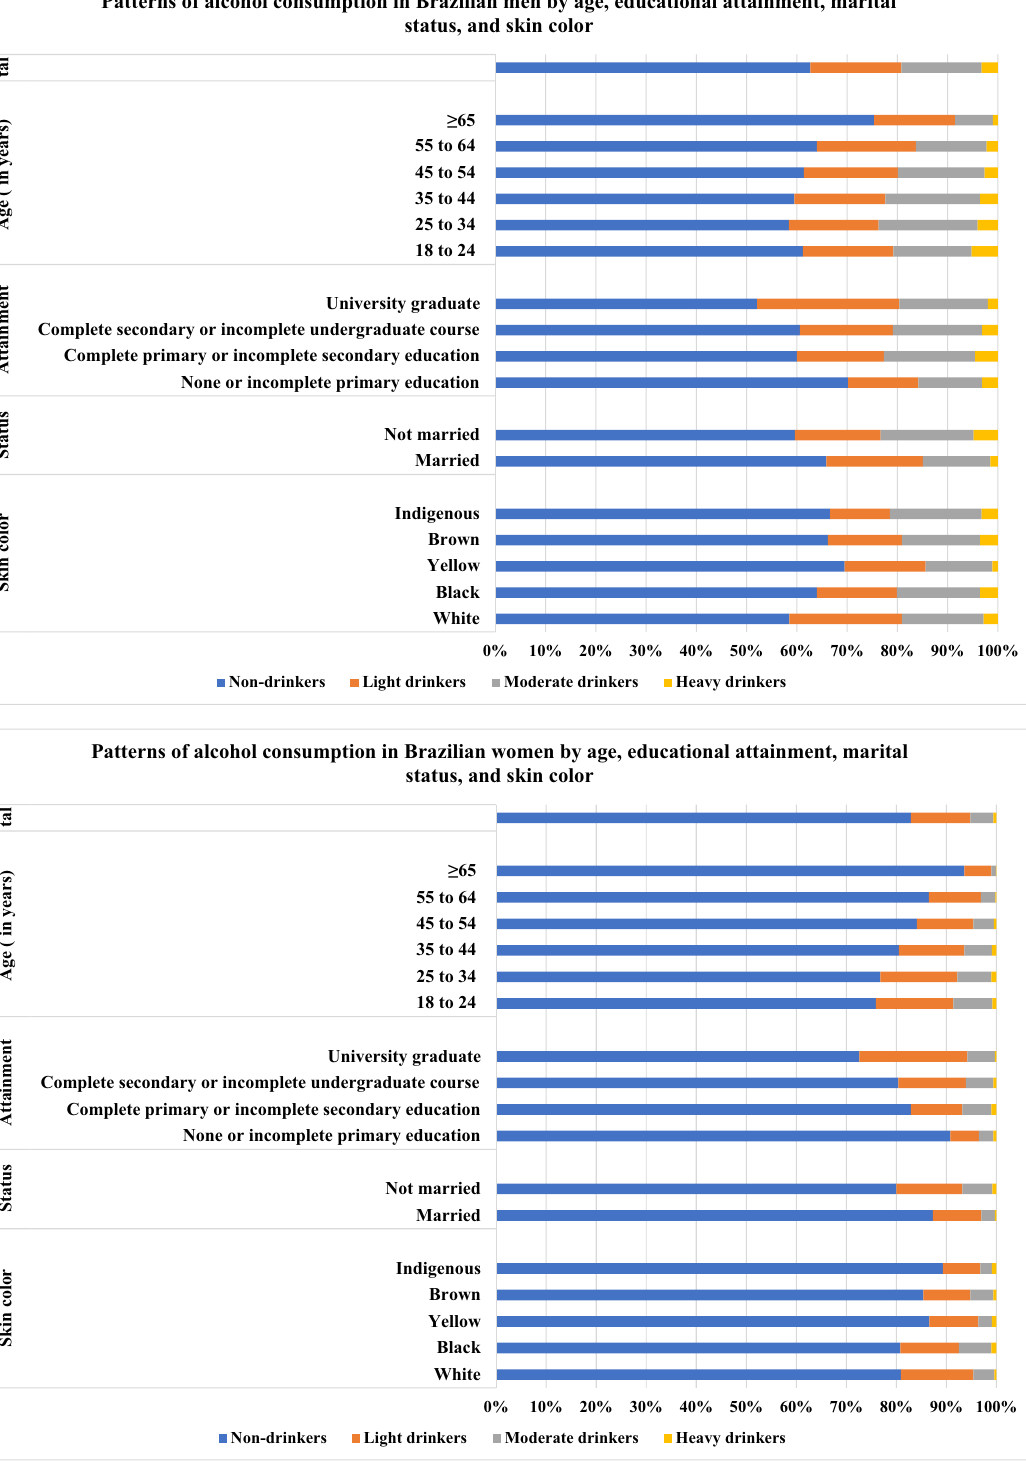
Figure 1. Patterns of alcohol consumption by sociodemographic characteristics in Brazilian adults. These figures show the patterns of alcohol consumption by sociodemographic characteristics according to sex. The prevalence corresponding to each pattern of alcohol consumption (non-drinker, light, moderate and heavy drinker) are presented in horizontal bars. The first line of each figure shows prevalence of patterns of alcohol consumption for the total sample of men or women, and the subsequent lines show prevalence for each sociodemographic characteristic: age, educational attainment, marital status and skin